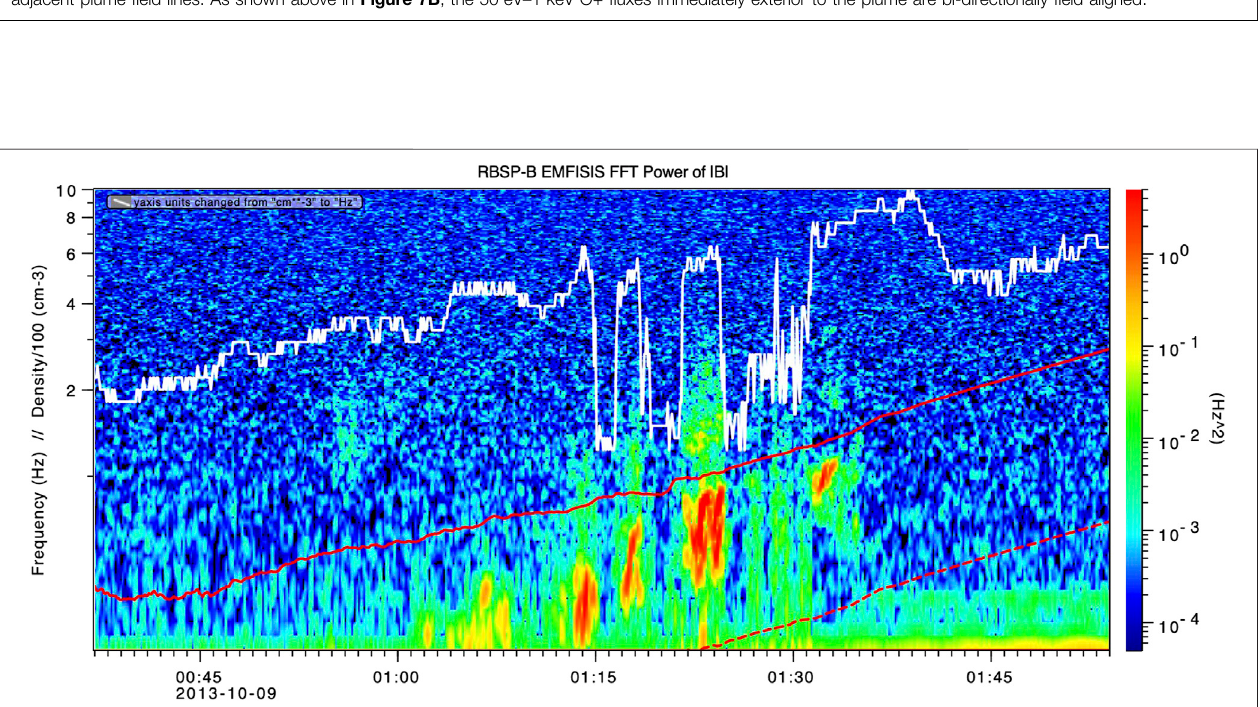
FIGURE 8 | Individual RBSP-B ion fl uxes immediately outside (red) and inside (black) the outer edge of the geospace plume are shown versus ion energy for the time indicated by the black vertical line in Figure 7A . The strong fl uxes of 10 eV – 1 keV O+ (A) , He+ (B) , and H+ (C) seen just outside the plume are excluded from adjacent plume fi eld lines. As shown above in Figure 7B , the 50 eV – 1 keV O+ fl uxes immediately exterior to the plume are bi-directionally fi eld aligned.